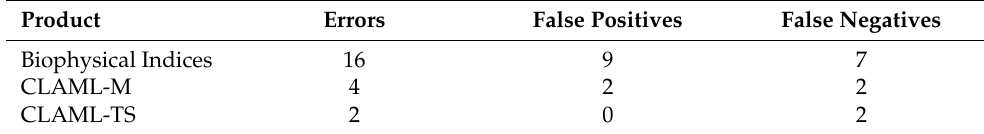
Table 8. Errors in batch of crop identification with individual treatment.